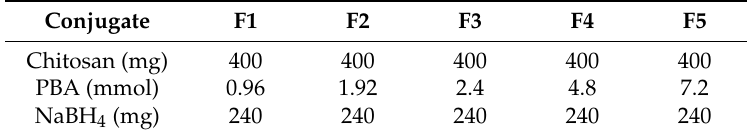
Table 1. Variations of 4-formylphenylboronic acid (PBA) used to formulate conjugates [25].